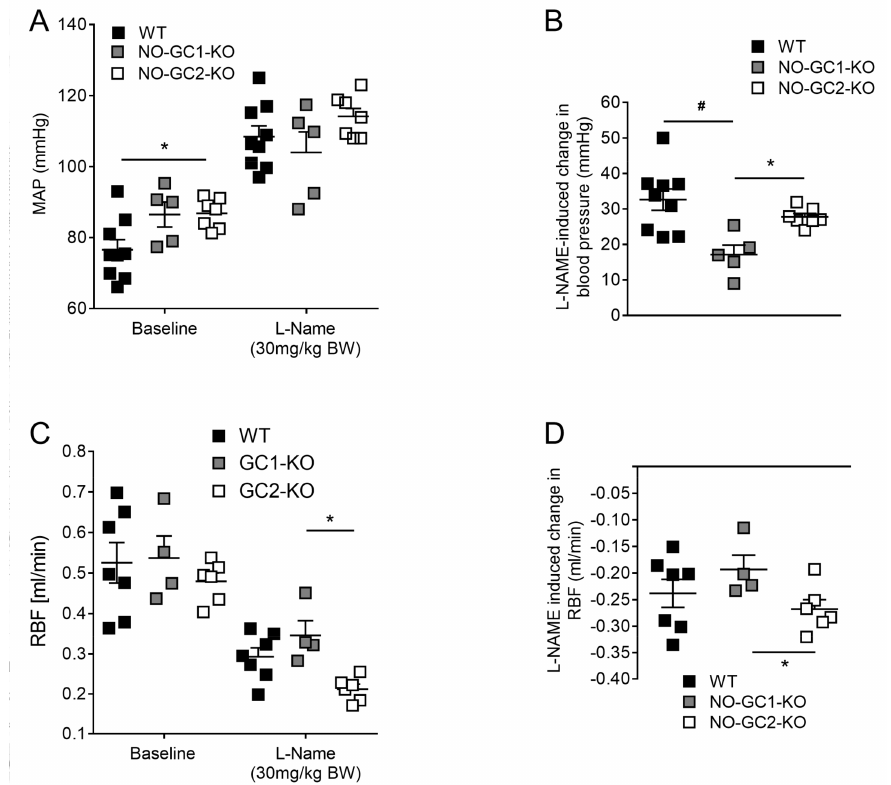
Figure 3. Inhibition of NO production by L-NAME affects blood pressure and renal blood flow in NO-GC1-KO and NO-GC2-KO mice. ( A ) In anesthetized mice, administration of L-NAME increased blood pressure to the same level; ( B ) L-NAME-induced blood pressure increase was significantly attenuated in NO-GC1-KO ( n = 5) and NO-GC2-KO ( n = 7) compared to WT ( n = 9) mice; ( C ) Renal blood flow was significantly decreased by L-NAME in WT ( n = 7), NO-GC1 ( n = 4) and NO-GC2-KO ( n = 6) mice; ( D ) L-NAME-induced reduction in renal blood flow was significantly reduced in NO-GC1-KO compared to NO-GC2-KO mice ( n = 4–7). * p < 0.05; # p < 0.01 vs. NO-GC2-KO. One-way ANOVA